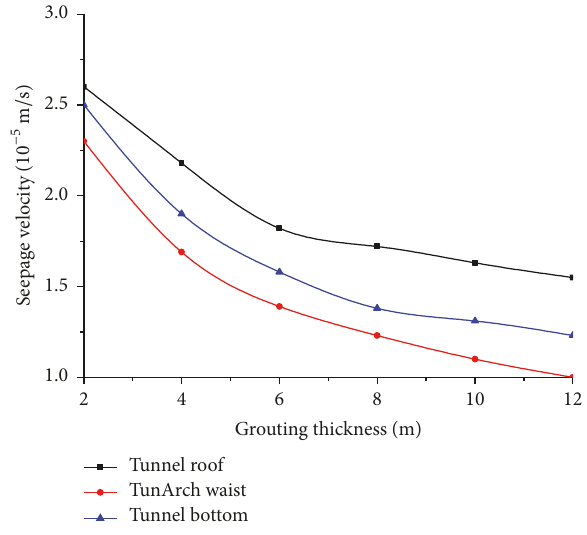
Figure 15: Flow velocity